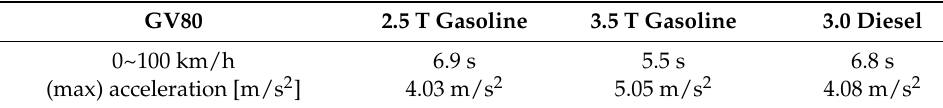
Table 2. Spec of GENESIS GV80 for estimation of